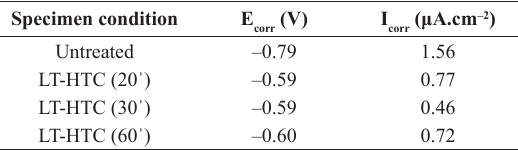
and i corr corr